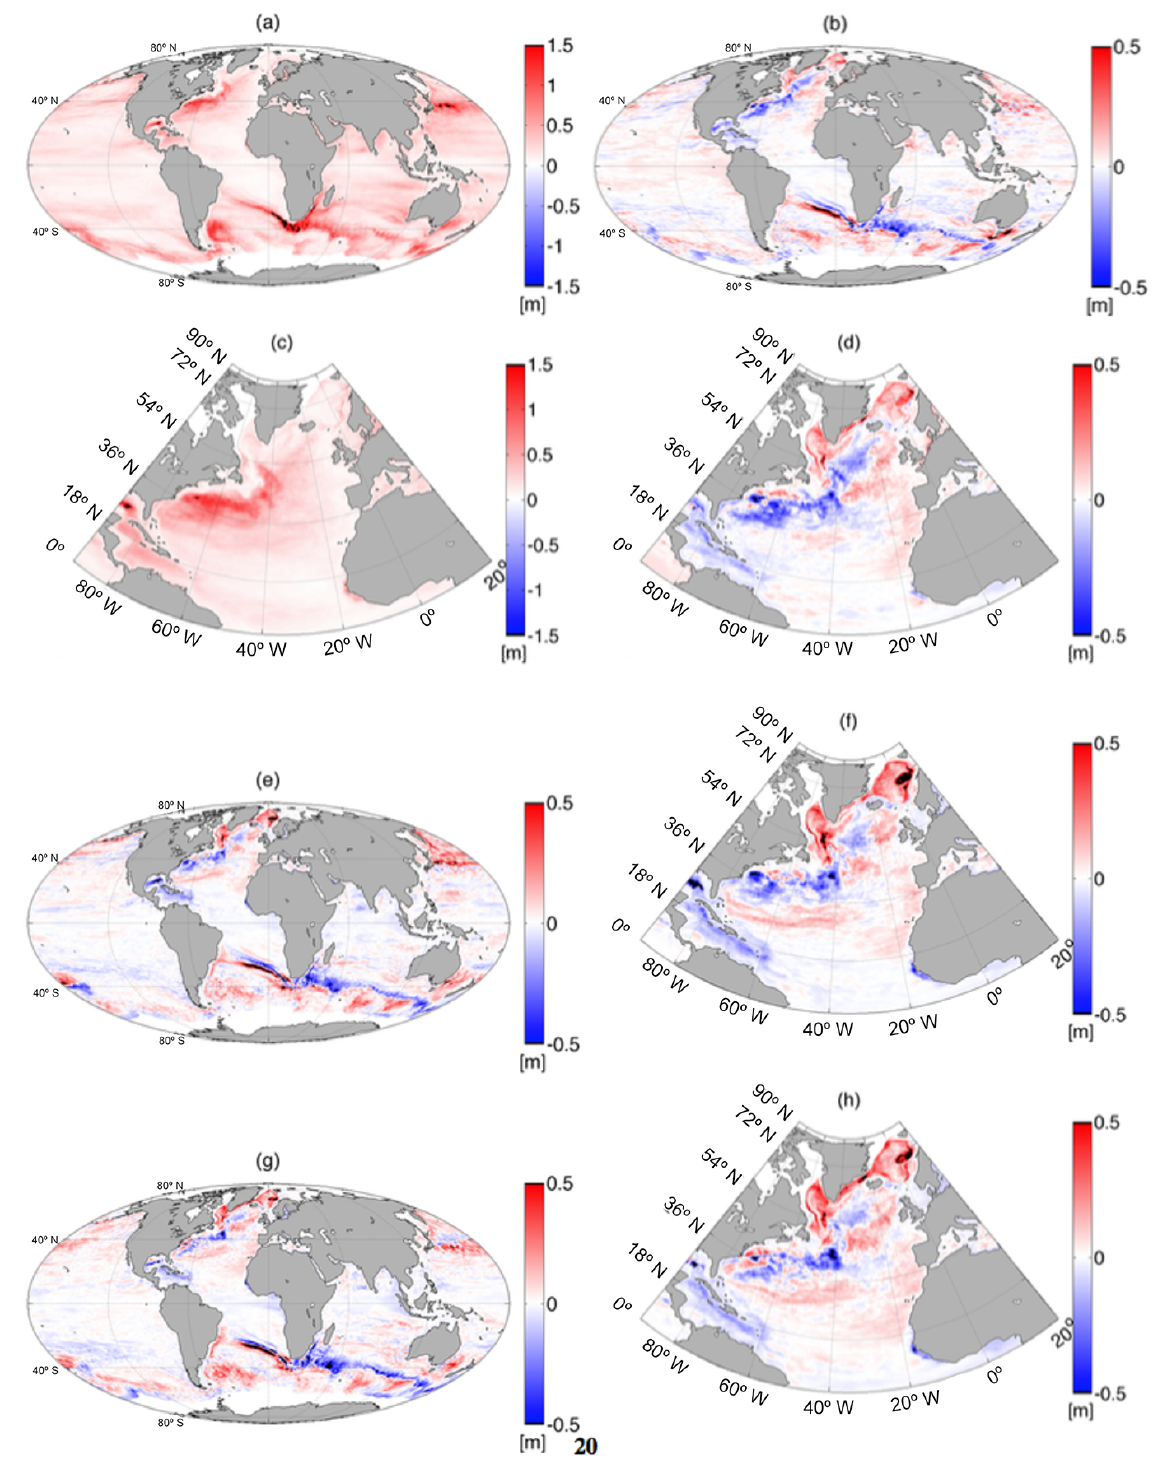
Figure 10. Extreme DSL values in meters for a 10-year return time of simulation R 021 for (a) the first 20 years (2001–2020) and (b) the differences between the period 2081–2100 and 2001–2020. All signals with frequencies lower than 550 days have been filtered out. The panels (c) and (d) are magnifications of (a) and (b) for the North Atlantic region. (e, f) and (g, h) are the differences between the